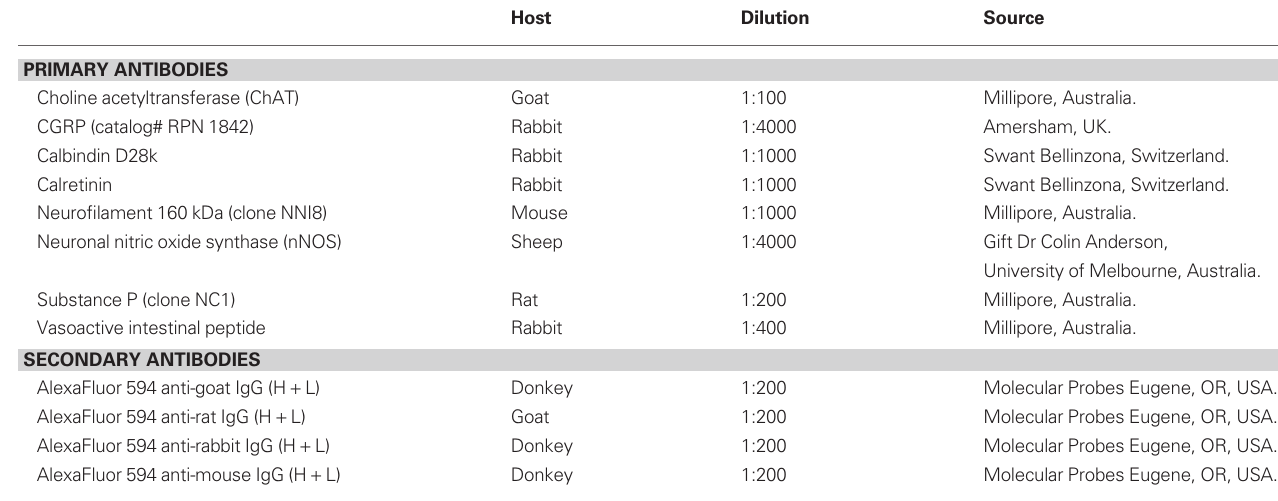
Table 1 | Details of primary and secondary antibodies used for immunohistochemical